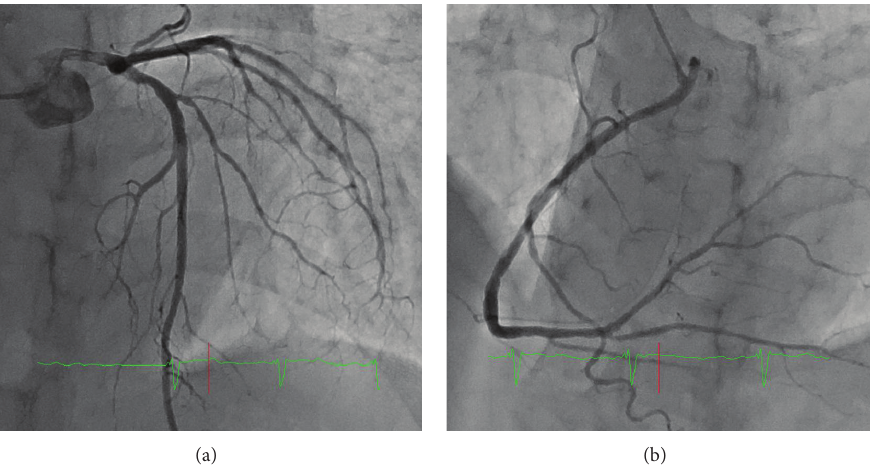
Figure 4: Coronary angiography showed no significant stenosis in the left (a) and right (b) epicardial arteries. Myocardial bridging was not observed.